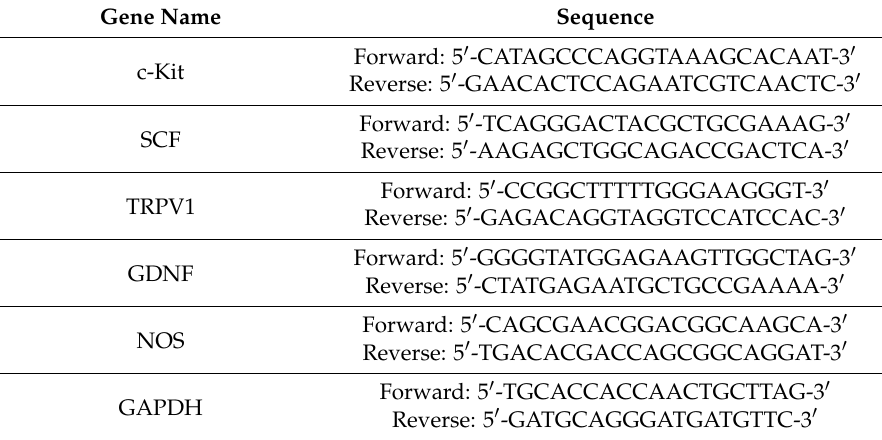
Table 1. Sequences of reverse transcription-polymerase chain reaction primers were used in this study.